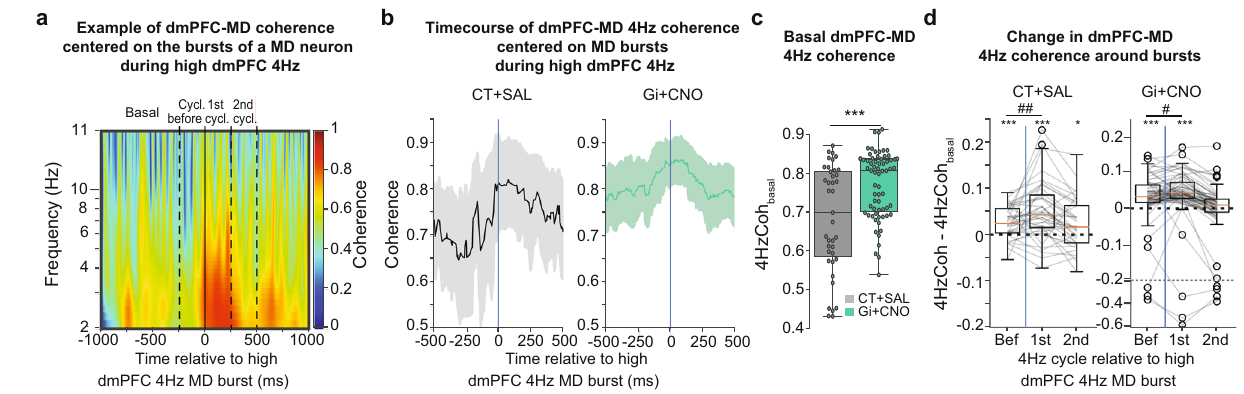
Fig.9|MDburstingisfollowedbyhigh4HzMD-mPFCcoherence.a Exampleof time frequency coherence analysis between dmPFC and MD LFP, centered on the bursting of a MD neuron during episodes of high 4Hz showing an increase of coherence in the 4Hz range after the burst. b , Average 4Hz coherence between dmPFC and MD LFP, centered on MD bursting during episode of high 4Hz for CT+SALmice(left)andGi+CNOmice(right),showinganincreaseofcoherencein the 4Hz range after the burst. c , Distributions of basal coherence between dmPFC and MD LFP before MD bursting ( − 1000ms to − 250ms) during episodes of high 4Hz. Mann – Whitney U test, *** p <0.001. d Distributions of increase in coherence